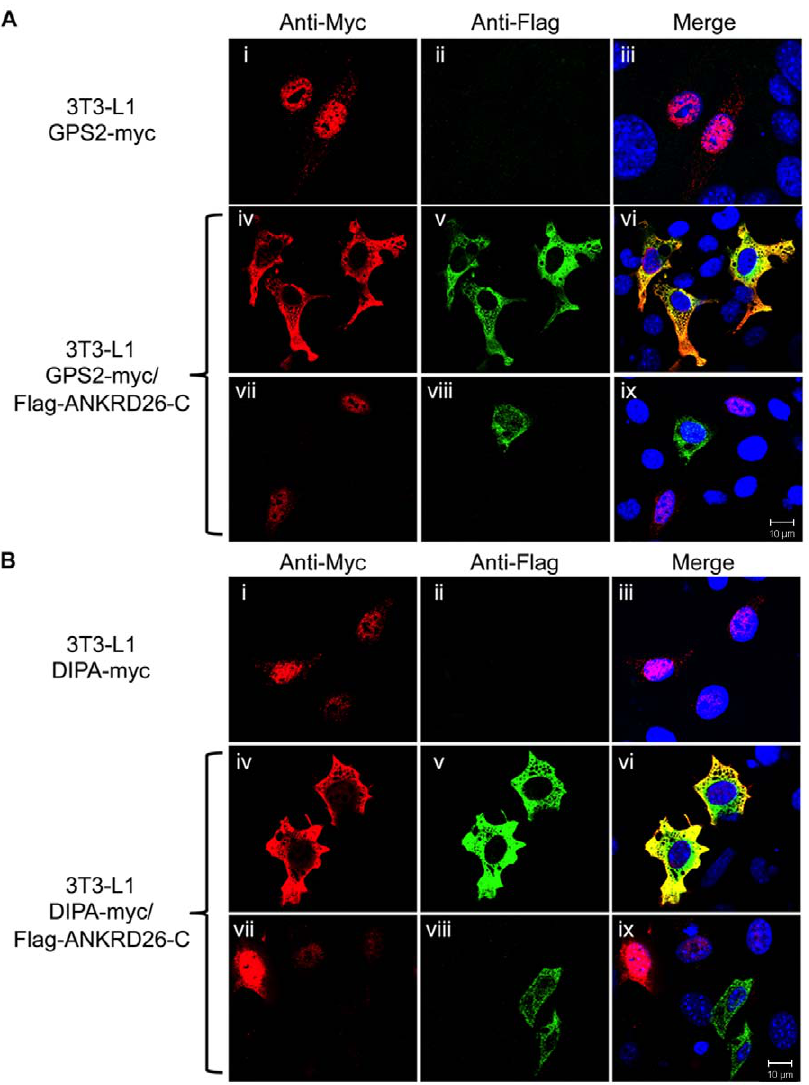
Figure 4. Nuclear localization of GPS2 and DIPA is affected in 3T3-L1 cells over-expressing Flag-ANKRD26-C. A ) 3T3-L1 cells transfected with GPS2-Myc (i–ix) and Flag-ANKRD26-C vectors (iv–ix) were double stained with antibodies against anti-Myc (i, iv, vii) and anti-Flag (ii, v, viii) and with DAPI solution for the nucleus staining (iii, vi, ix). B ) 3T3-L1 cells transfected with DIPA-myc (i–ix) and Flag-ANKRD26-C vectors (iv–ix) were stained as in B . The images labeled iii, vi and ix are the merged fluorescent images. Note that only co-transfected cells in Panels vii, viii and ix demonstrate cytosolic localization on GPS2 and DIPA.